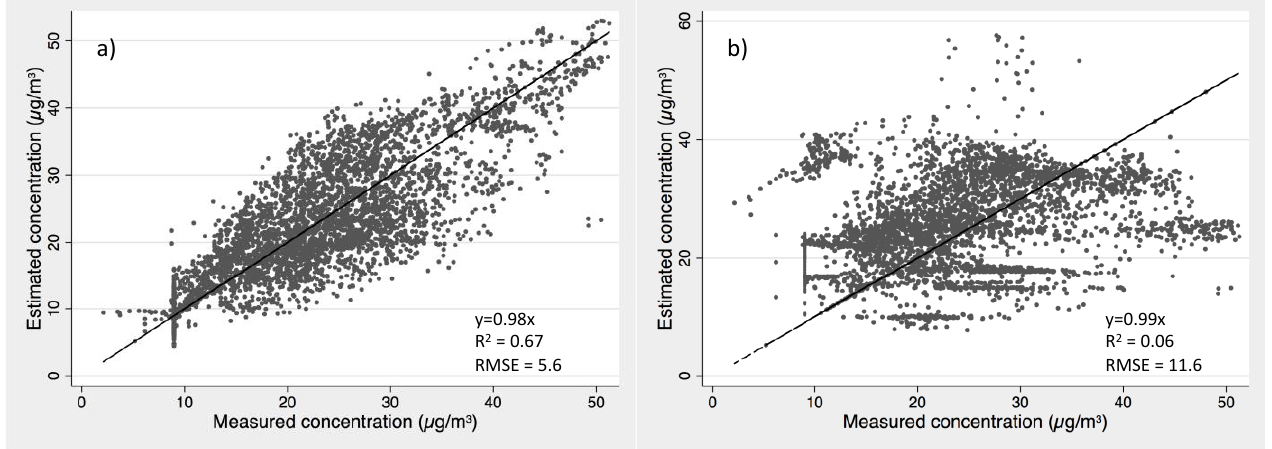
Figure 7. Predicted HCHO concentrations versus measured concentrations in 27 selected houses using ( a ) estimated emission rate by the proposed model with averaged coefficients across homes and ( b ) estimated emission rate by a traditional approach that using a fixed floor area normalized emission rate averaged across 27 homes.